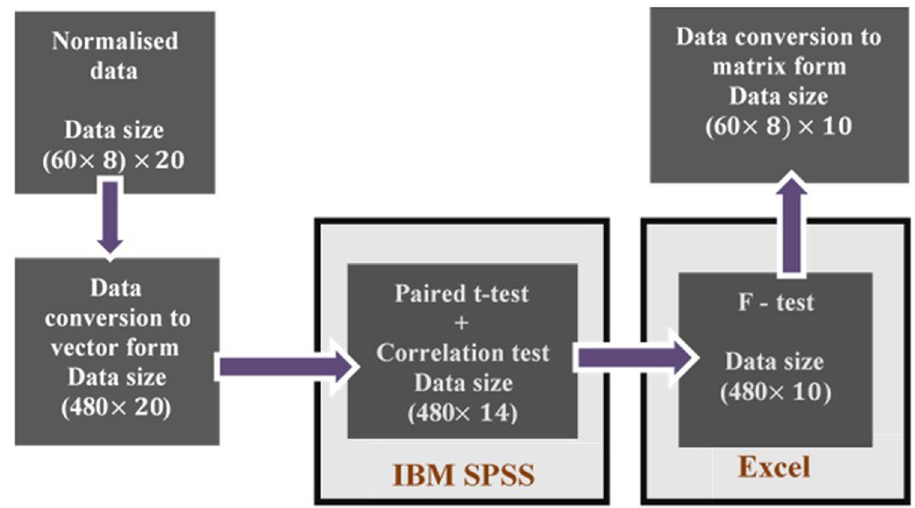
Figure 4. Normalization methods selection